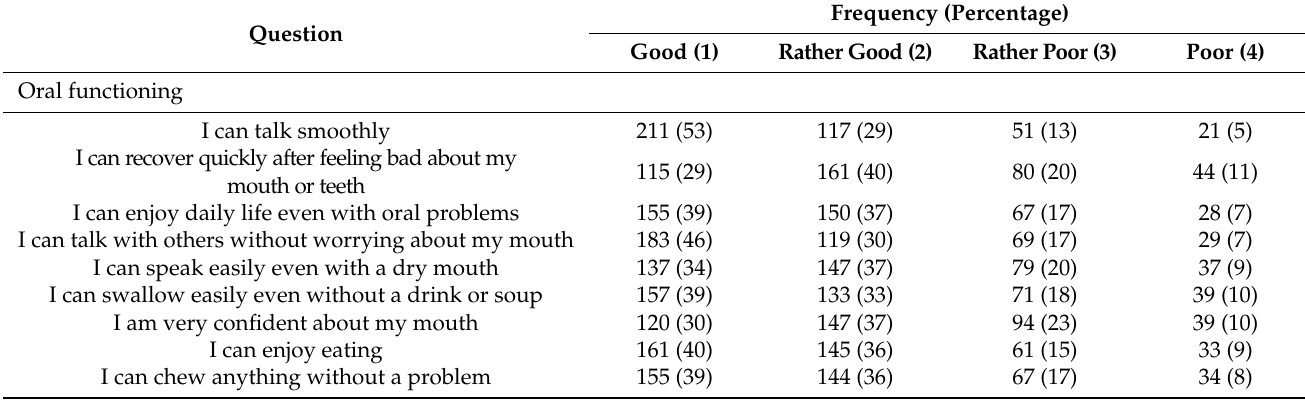
Table 2. Distribution of participants according to self-perception using GSEOH